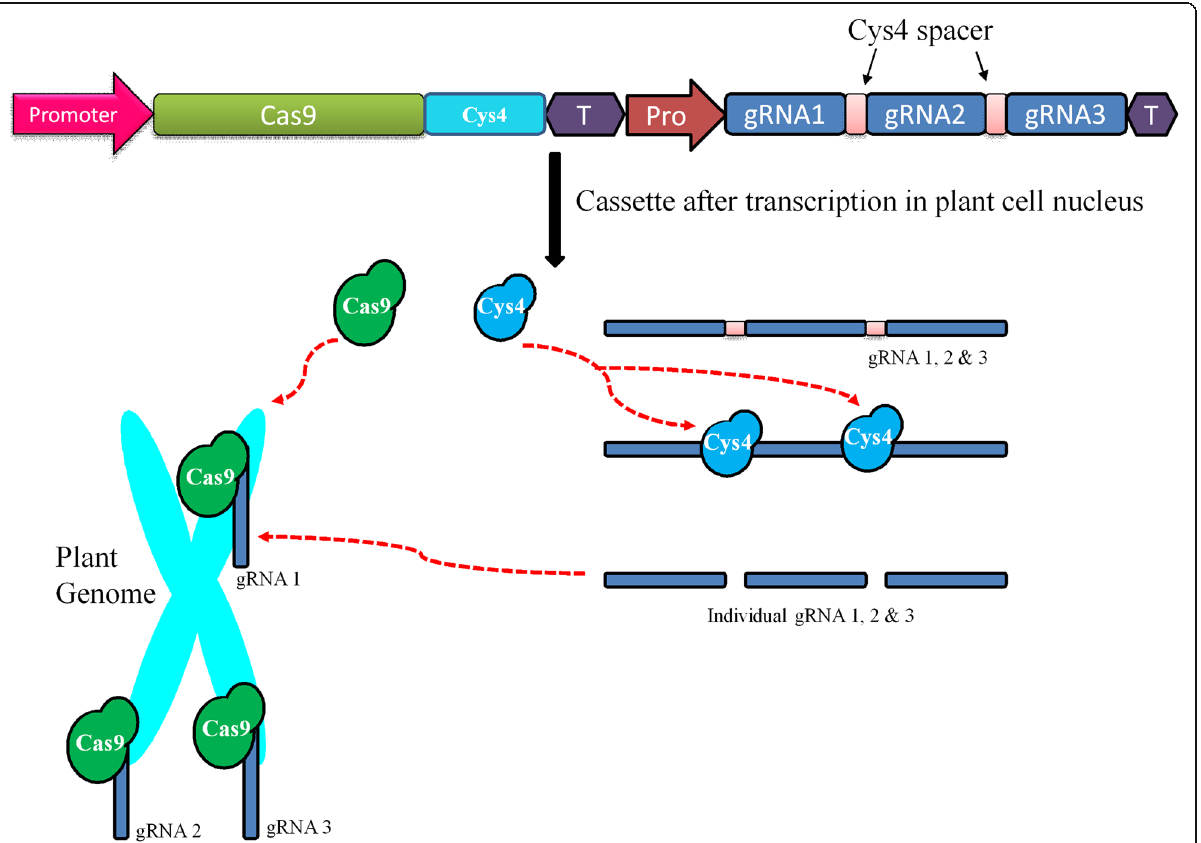
Fig. 3 Mechanism of Cas9/polycistronic-Csy4-gRNA complexes mediated editing of the genome. A CRISPR/Cas9 construct containing promoter (Pro), Cas9 , Csy4 , terminator (T), and guide RNA (gRNA1, 2, and 3). Construct delivered into plant cells and transcribed into nucleus. The transcript of Cas9 and Cys4 will translated into proteins (nucleases), whereas multicistronic gRNA are separated into individual sgRNAs (dark blue boxes) due to action of Cys4 nucleases (sky blue circles). Further, gRNA1, 2, and 3 scan their respective target sites where Cas9 (green circles) binds and breaks the